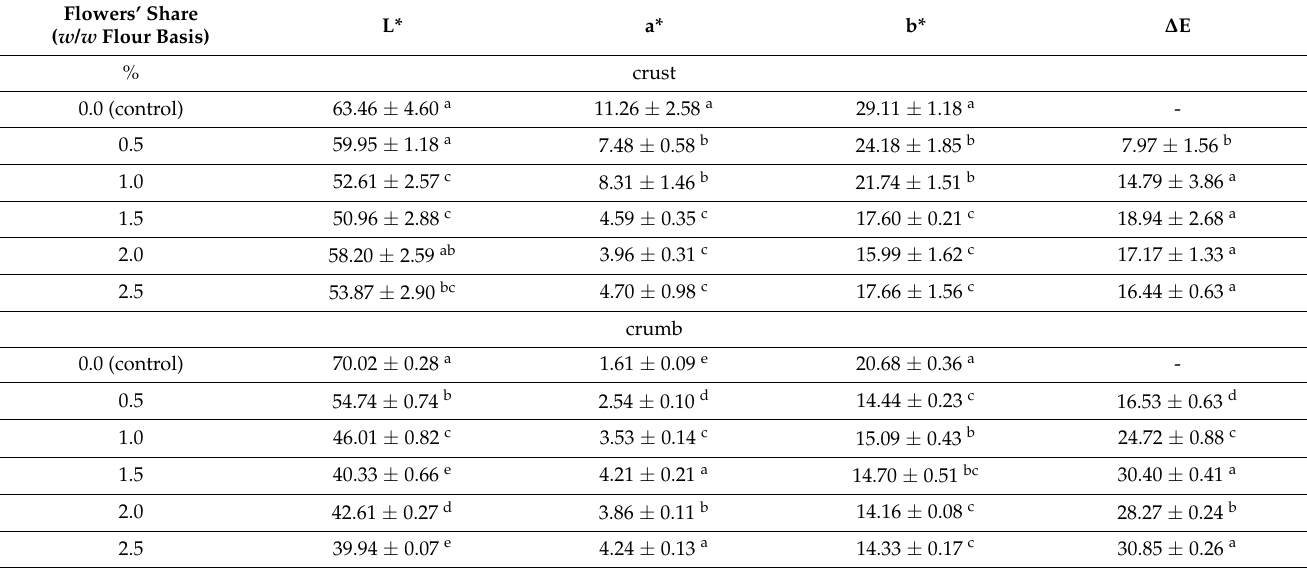
Table 4. Color of wheat bread enriched with J. regia male flowers.